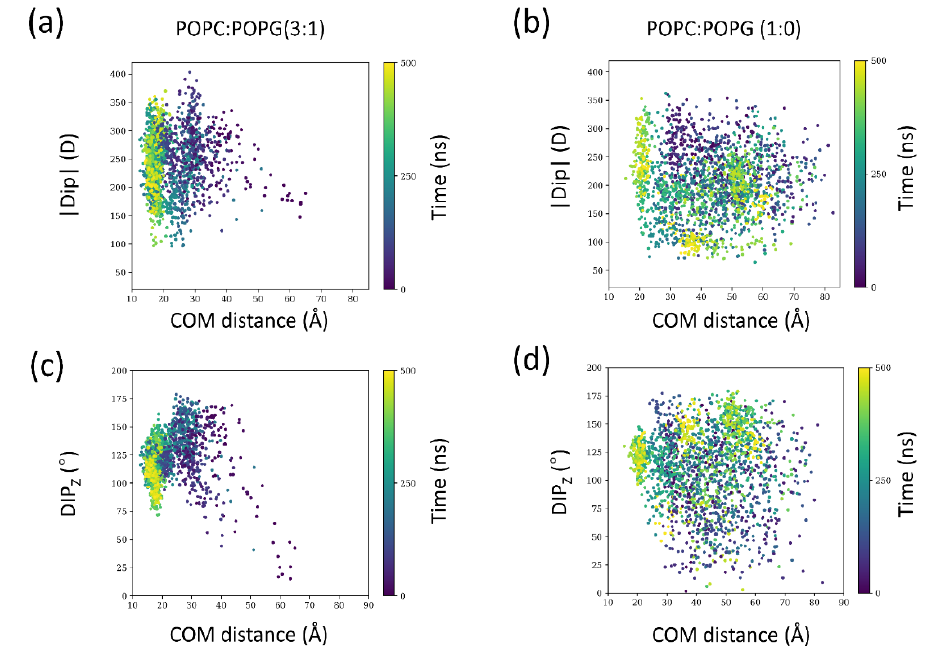
Figure 6. Dipolar interactions as a function of membrane distance. ( a ) dipole magnitude (|Dip|) and ( c ) dipole angle (Dip z ) to the z-axis of SNX-482 for the 3:1 system. ( b ) dipole magnitude and ( d ) dipole angle with respect to the positive z-axis of SNX-482 for the 1:0 system. Points are colored according to the time in the simulation. In each condition, data from all four simulations were included. The data was obtained from the four unrestrained AT simulations displaying spontaneous binding simulations.